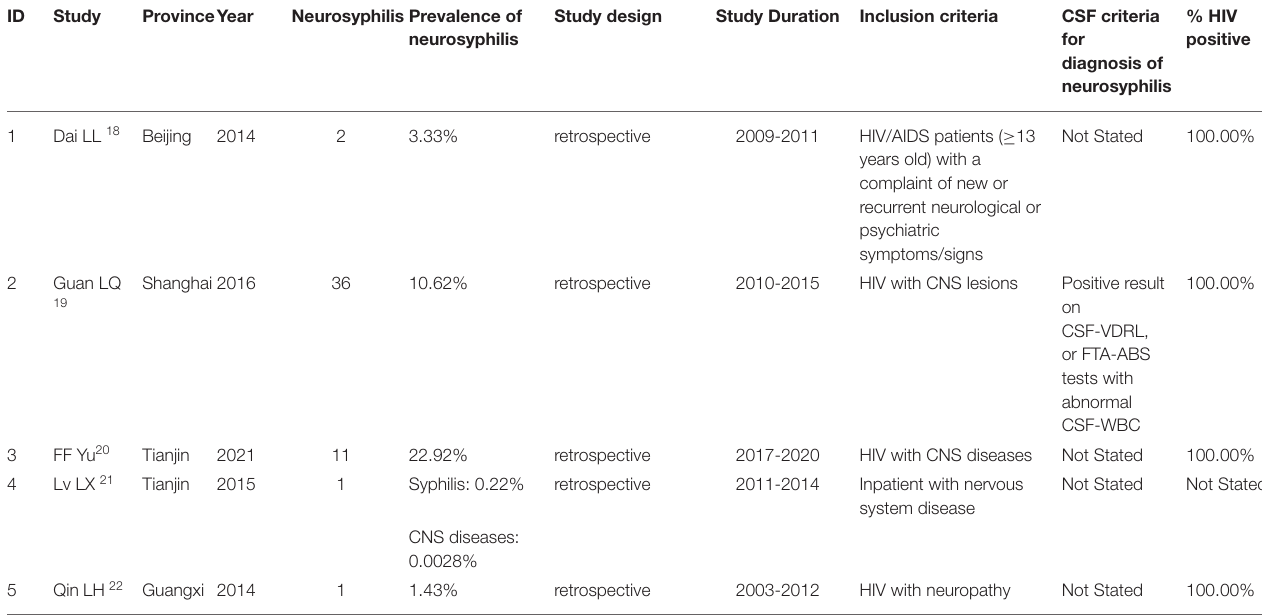
TABLE 4 | Studies reporting cases of neurosyphilis with CNS